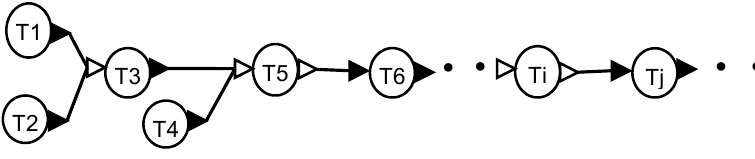
Figure 9. Front-end driven recipe patterns with decoupling subtask.